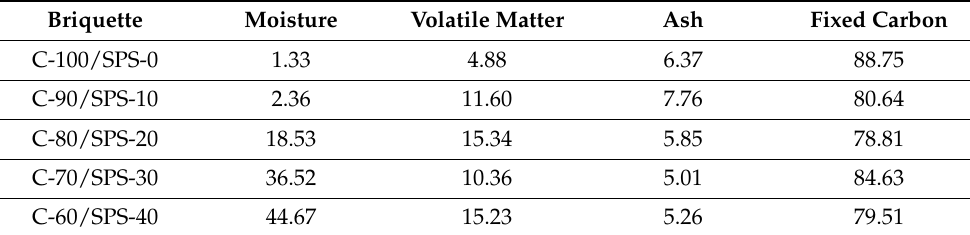
Table 3. Proximate analysis of the briquettes